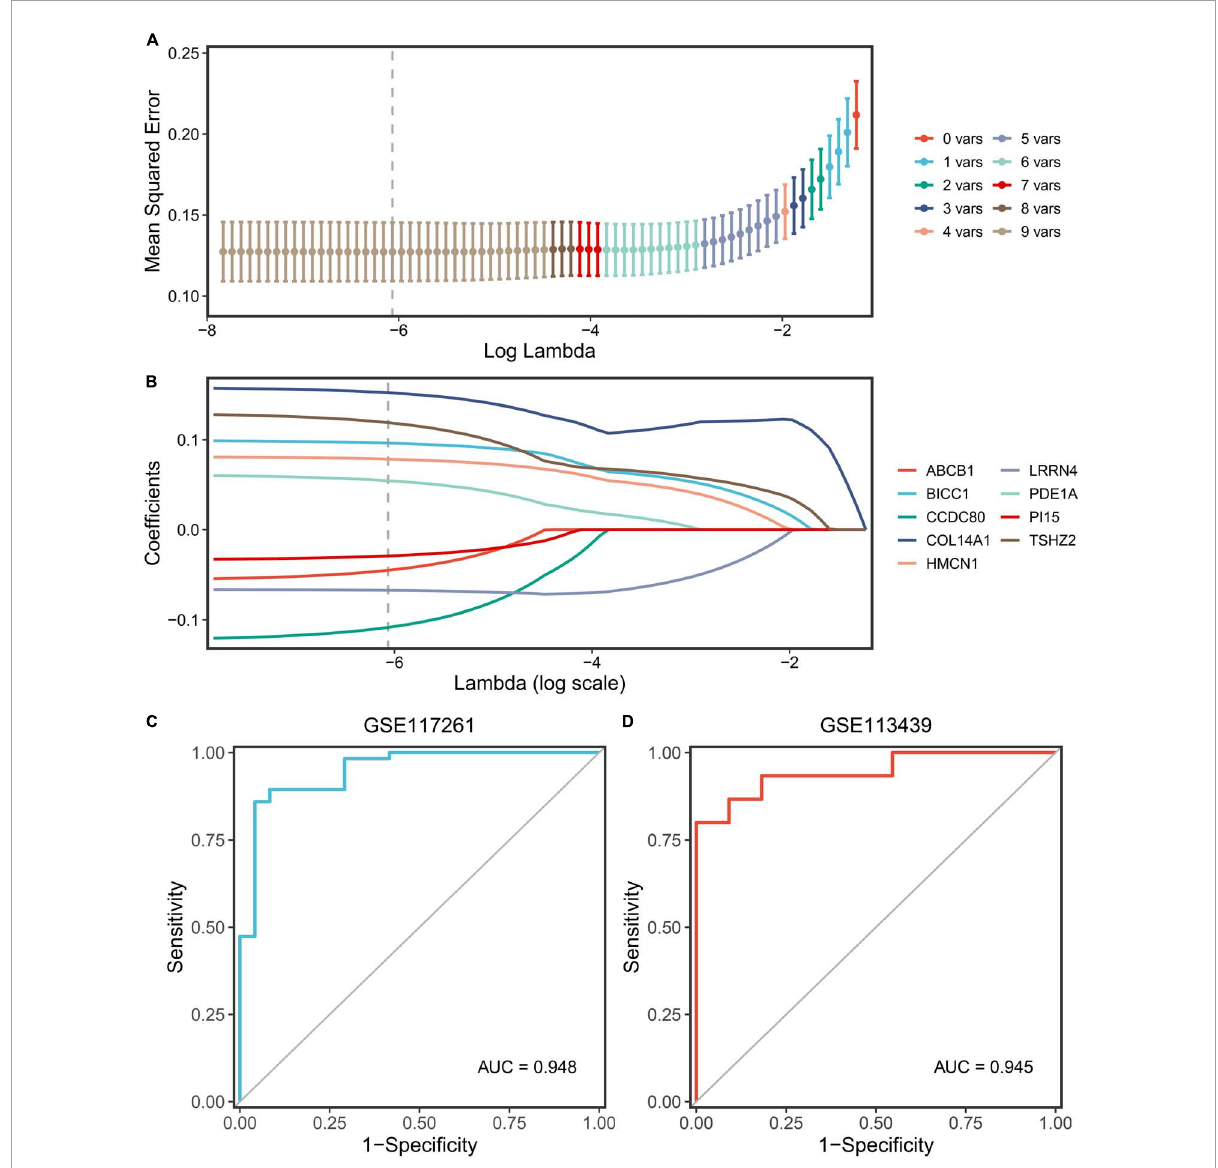
FIGURE6 Screening and validation of the genes. (A) Determination of the optimal lambda was obtained when the partial likelihood deviance reached the minimum value and further generated the key gene with non-zero coefficients. (B) LASSO coefficient profiles of the candidate gene for PDS construction. (C) The ROC curve of the modeling dataset (GSE117261). (D) The ROC curves of validation datasets